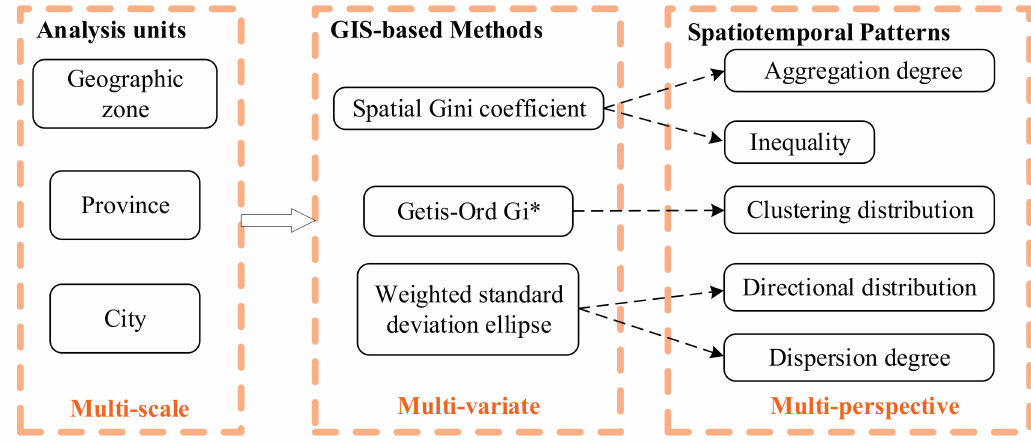
Figure 2. The “3M” framework for spatiotemporal analysis of traditional villages in